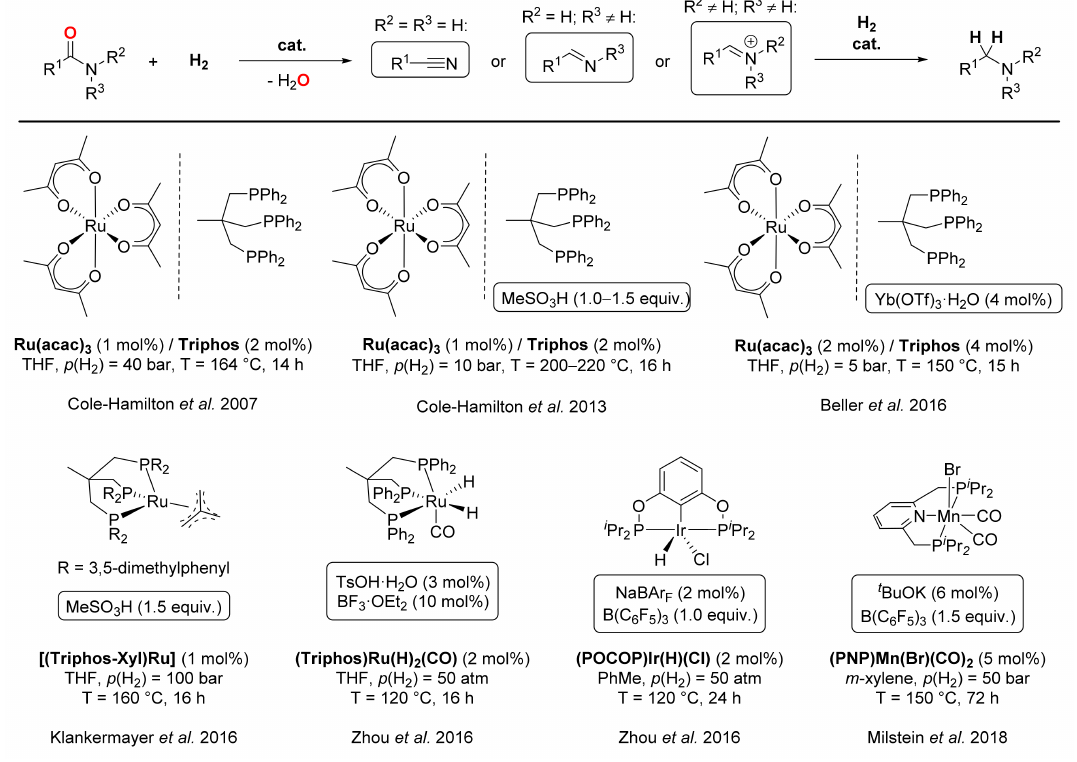
Scheme 30. Homogeneous transition metal catalysts for deoxygenative hydrogenation of